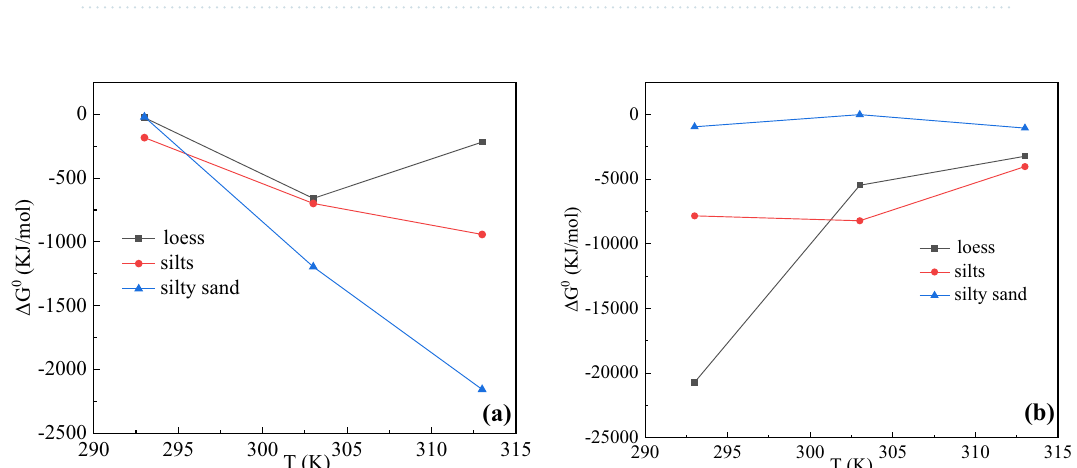
Figure 4. ( a ) Effect of temperature on phenanthrene adsorption free energy in the three tested soils. ( b ) Effect of temperature on phenanthrene desorption free energy in the three tested